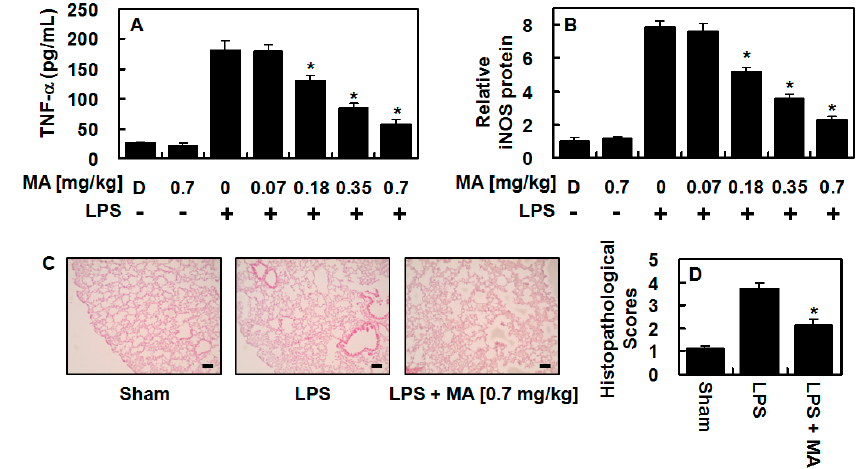
Figure 4. In LPS-injected mice, MA suppressed the levels of TNF- α and iNOS and alleviated lung tissue injury. LPS (15 mg/kg, i.p.) was injected first and MA (0.07–0.7 mg/kg, i.v.) was administered 6 h after LPS injection. Control mice were not injected with LPS. Five mice were used for each LPS and MA treated/LPS nontreated, control group. Lung tissue and bronchoalveolar lavage fluid (BALF) were collected when the mice were sacrificed 1 d after the LPS challenge, and the levels of TNF- α ( A ) and iNOS ( B ) were analyzed. The results represent the mean value with SD from three independent experiments performed in triplicates on three different days. D denotes 0.2% DMSO, which was used as the vehicle control. ( C ) Hematoxylin and eosin (H&E) staining of lung tissues from each group was conducted and representative images from three independent experiments performed on three different days are shown. The bar represents 100 µm. ( D ) Histopathological scores for the lung tissue were recorded as described in the methods section. * p < 0.05 versus LPS.